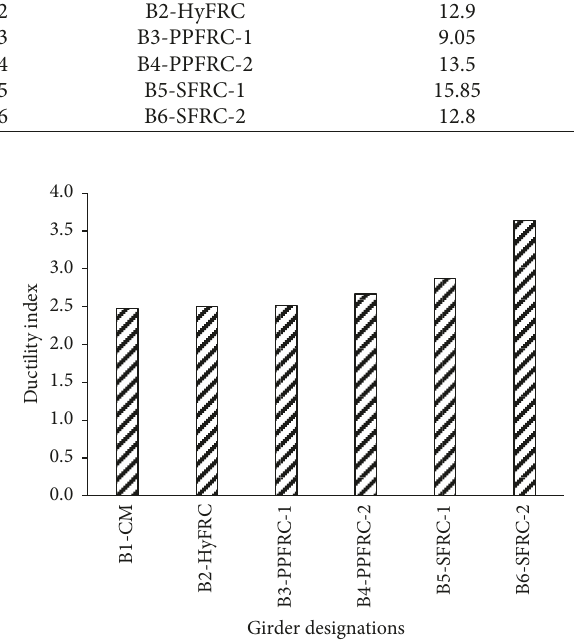
Figure 13: Ductility index of all girders.